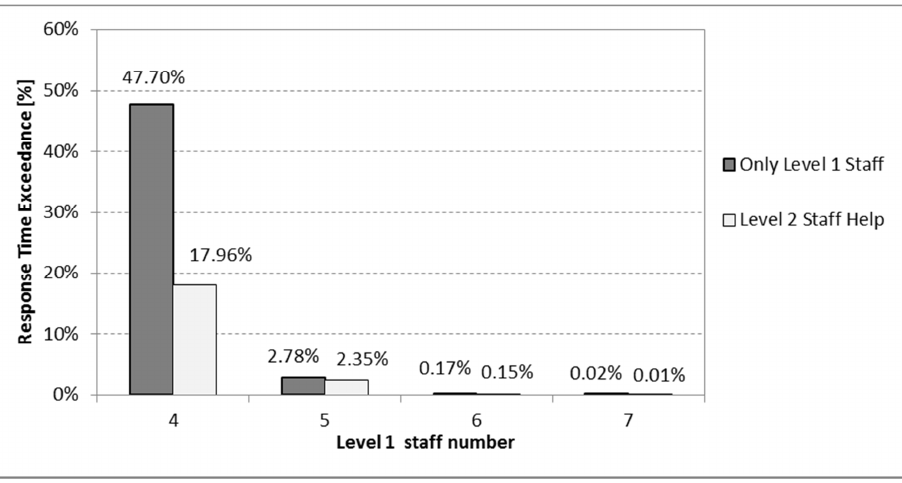
Figure 5 – Comparison of response time